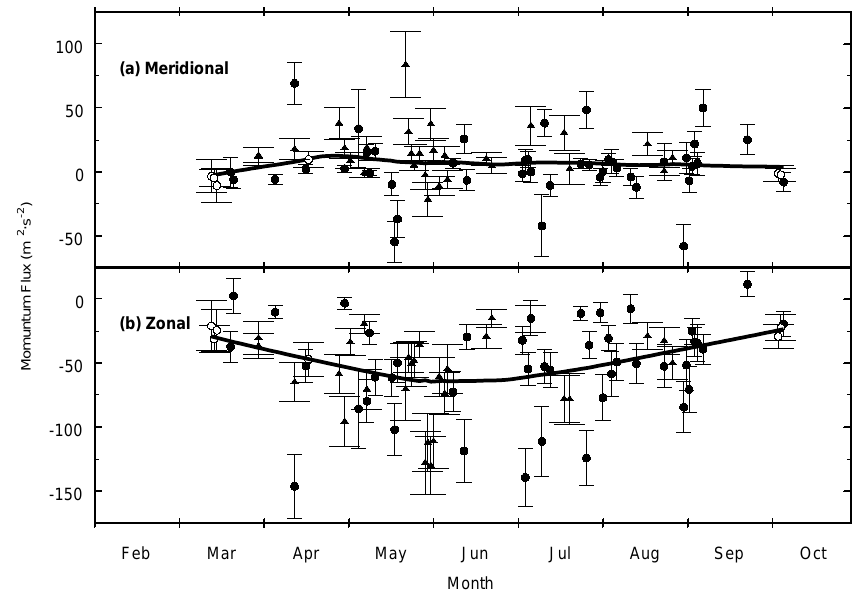
Fig. 4. The daily meridional (a) and zonal (b) momentum fluxes for the years 2002 and 2003 at Rothera. The data for 2002 are represented by circles and those for 2003 are given by the triangles. Data for which there are no coincident MF-radar winds are shown by the open symbols, and the solid lines are a weighted least-squares fit to the